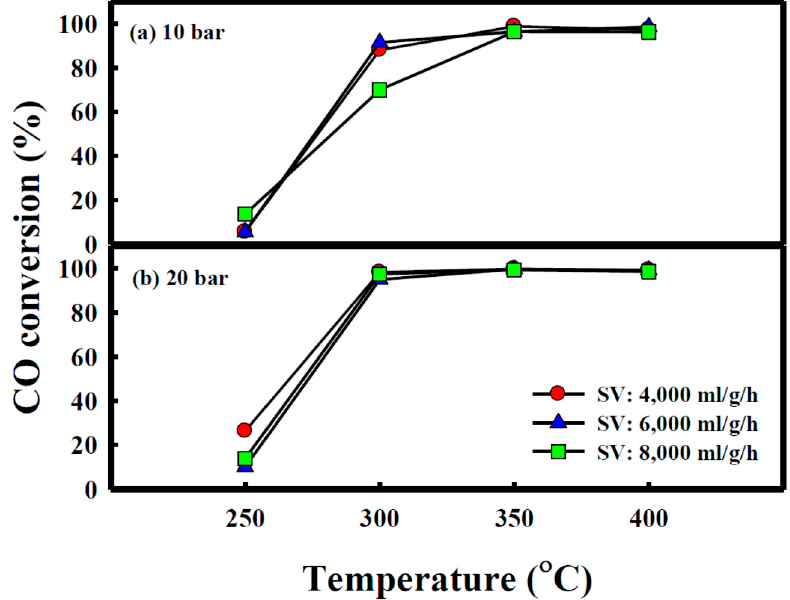
Figure 19. The initial CO conversion under ( a ) 10 and ( b ) 20 bar at different space velocities as a function of reaction temperature [105].